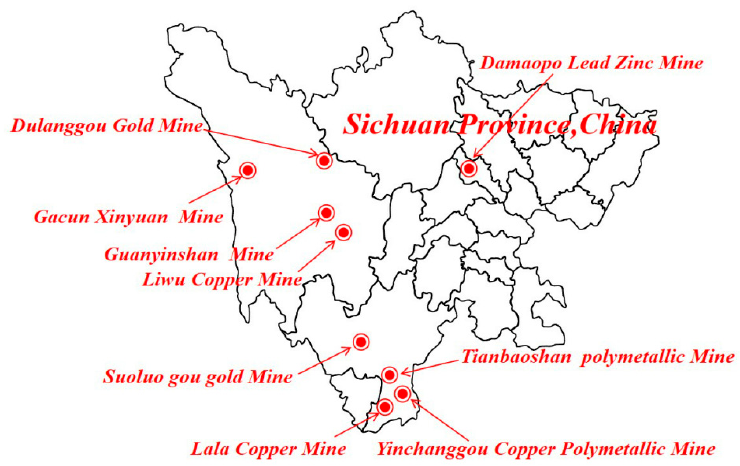
Figure 12. The locations of the nine metal mines. Table 4. Application of the WOA–RF model in practical engineering.